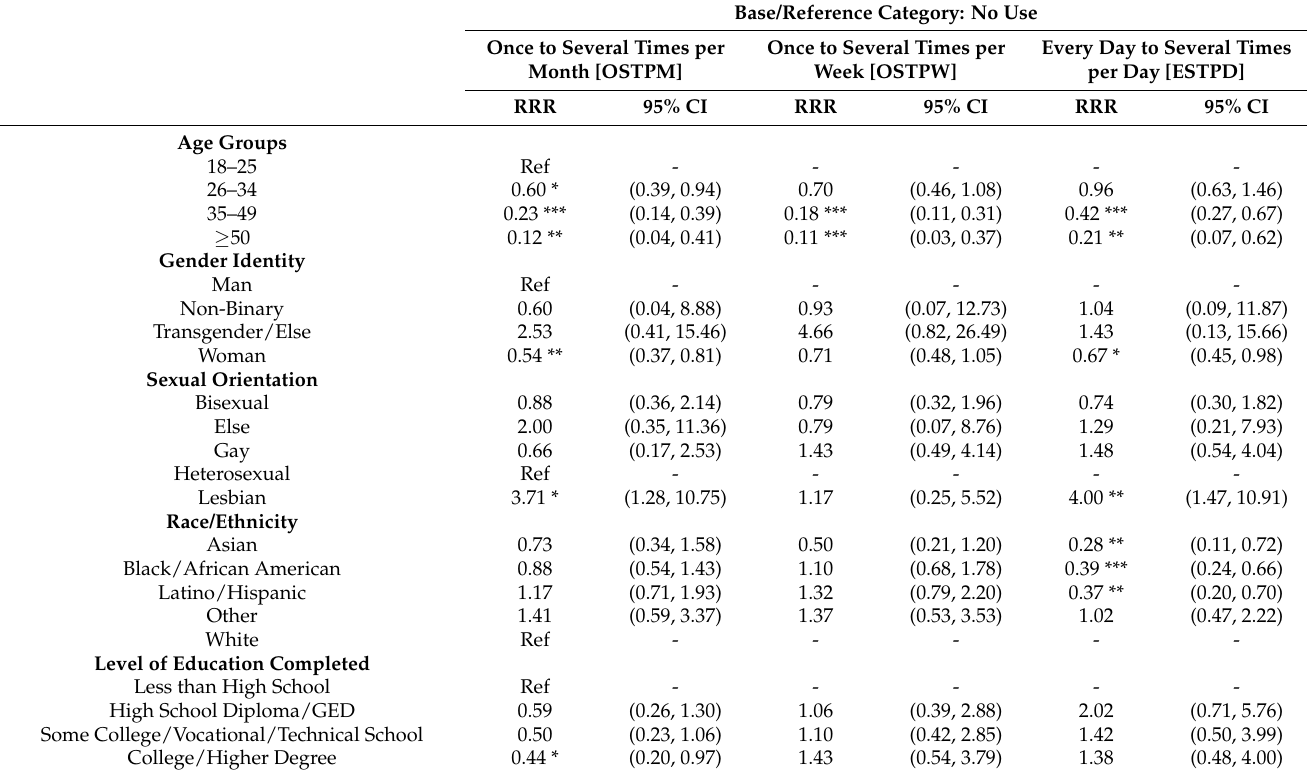
Table 2. Multinomial logistic regression analysis of past-month e-cigarette use and its associations with sociodemographic characteristics, the likelihood of contracting COVID-19, social interaction, substance use, and mental health